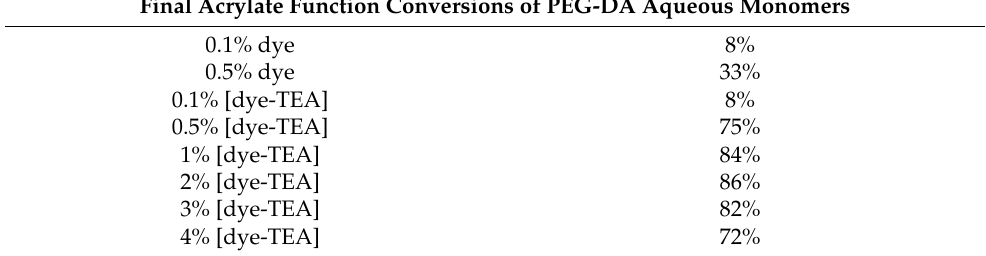
Table 1. Summary of the final function conversions of waterborne monomers (PEG-DA) under LED @ 405 nm initiated by dye (0.1 wt%, 0.5 wt%) and [dye-TEA] (0.1 wt%, 0.5 wt%, 1 wt%, 2 wt%, 3 wt%, 4 wt%) in laminate upon LED @ 405 nm with a thickness of about 2